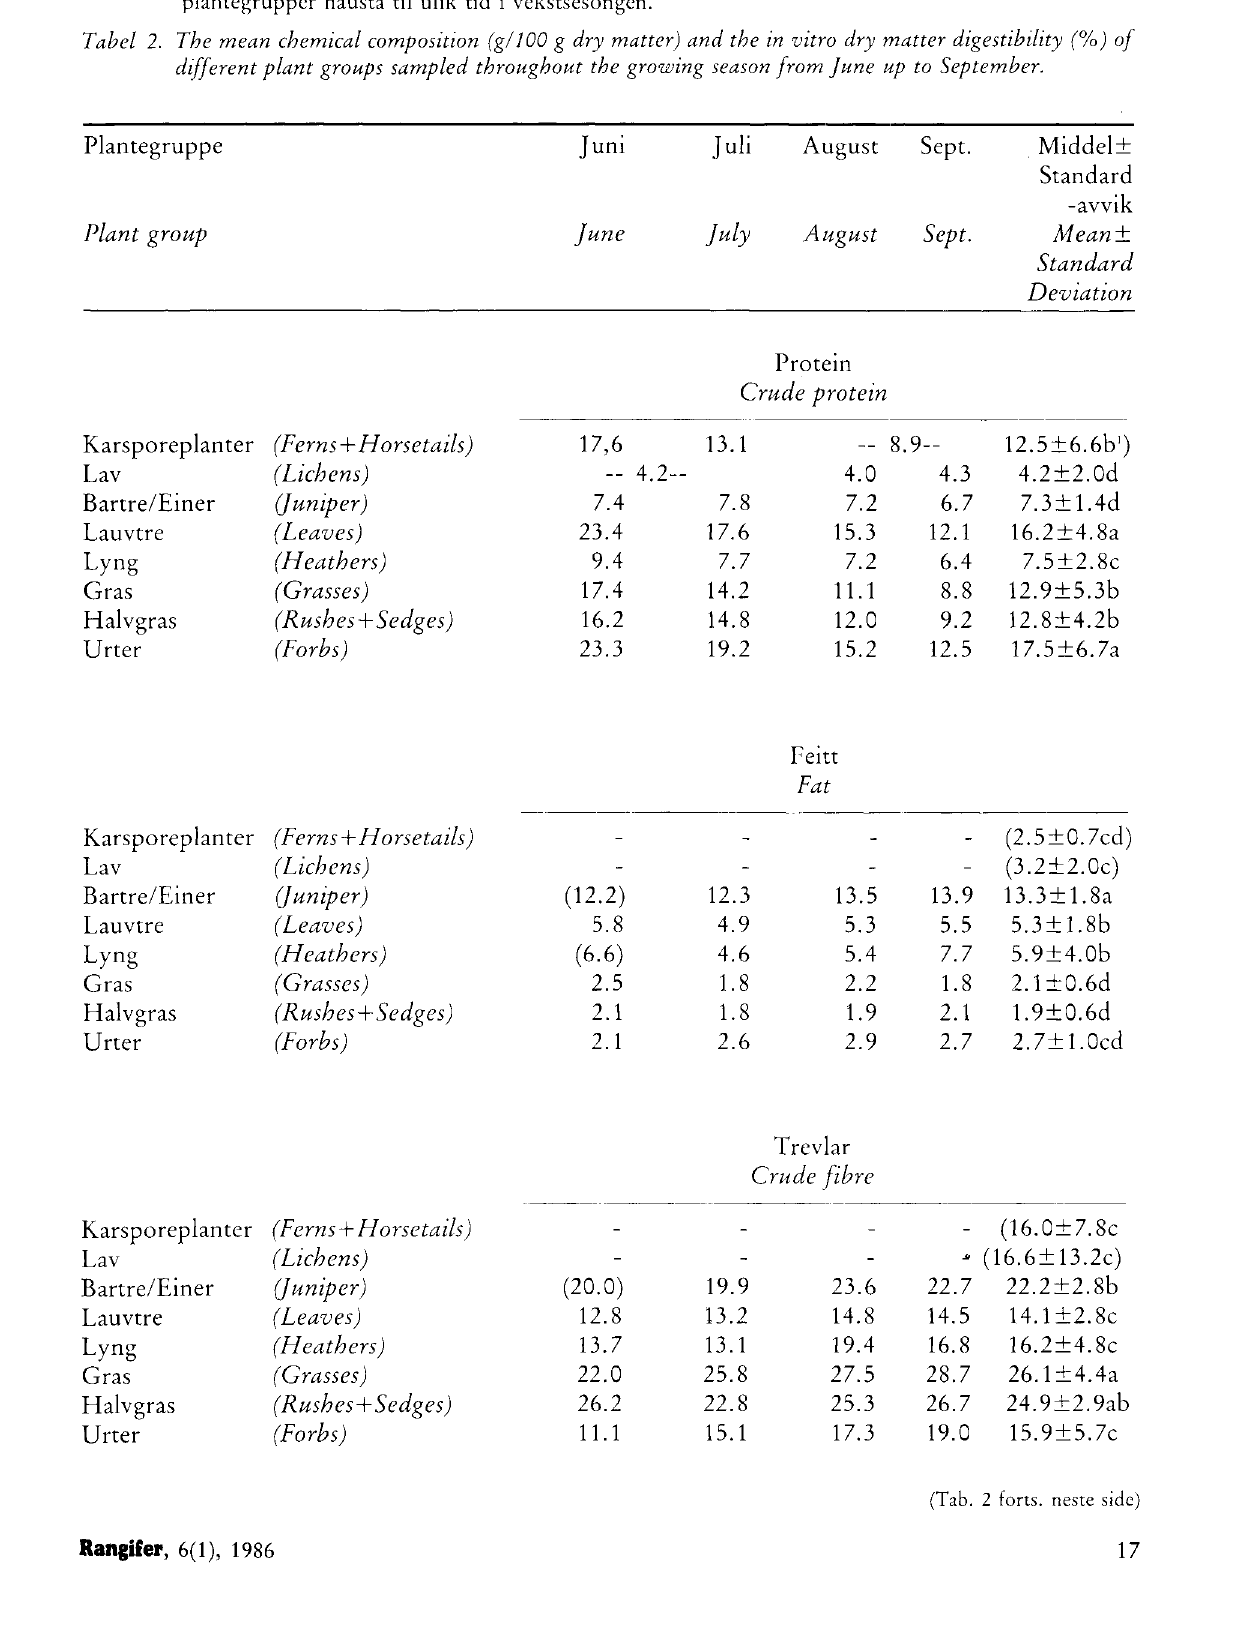
Tabell 2. Kjemisk innhald (g/100 g tørrstoff) og fordøyelsesgrad av plantetørrstoffet (in vitro, %) i ulike plantegrupper hausta til ulik tid i vekstsesongen. Tabel 2. The mean chemical composition (g/100 g dry matter) and the in vitro dry matter digestibility (%) of different plant groups sampled throughout the growing season from June up to September.